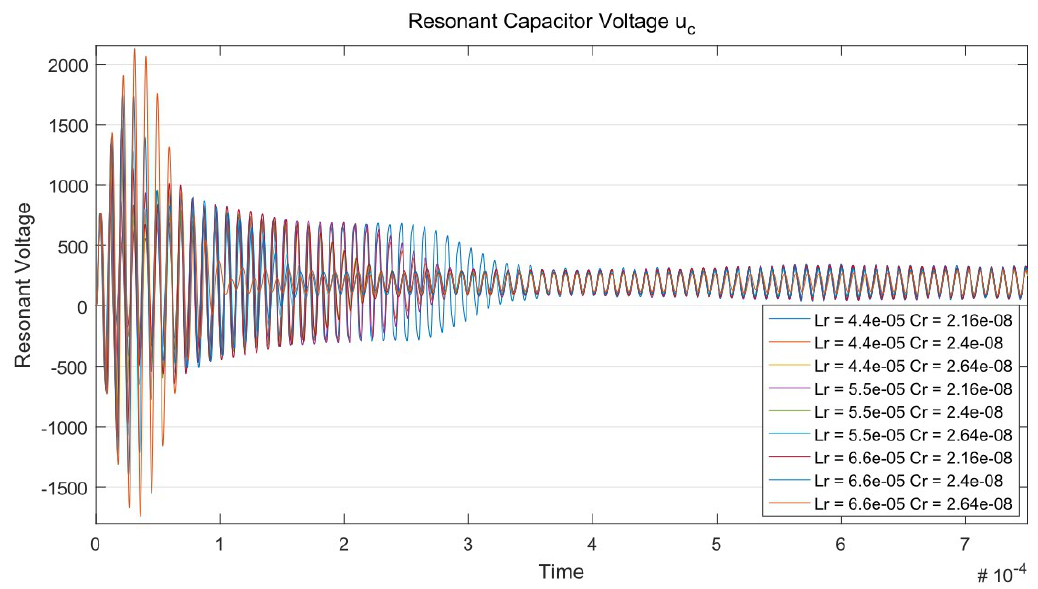
Figure 9. Tolerance analysis of the transient response of the resonant capacitor voltage.